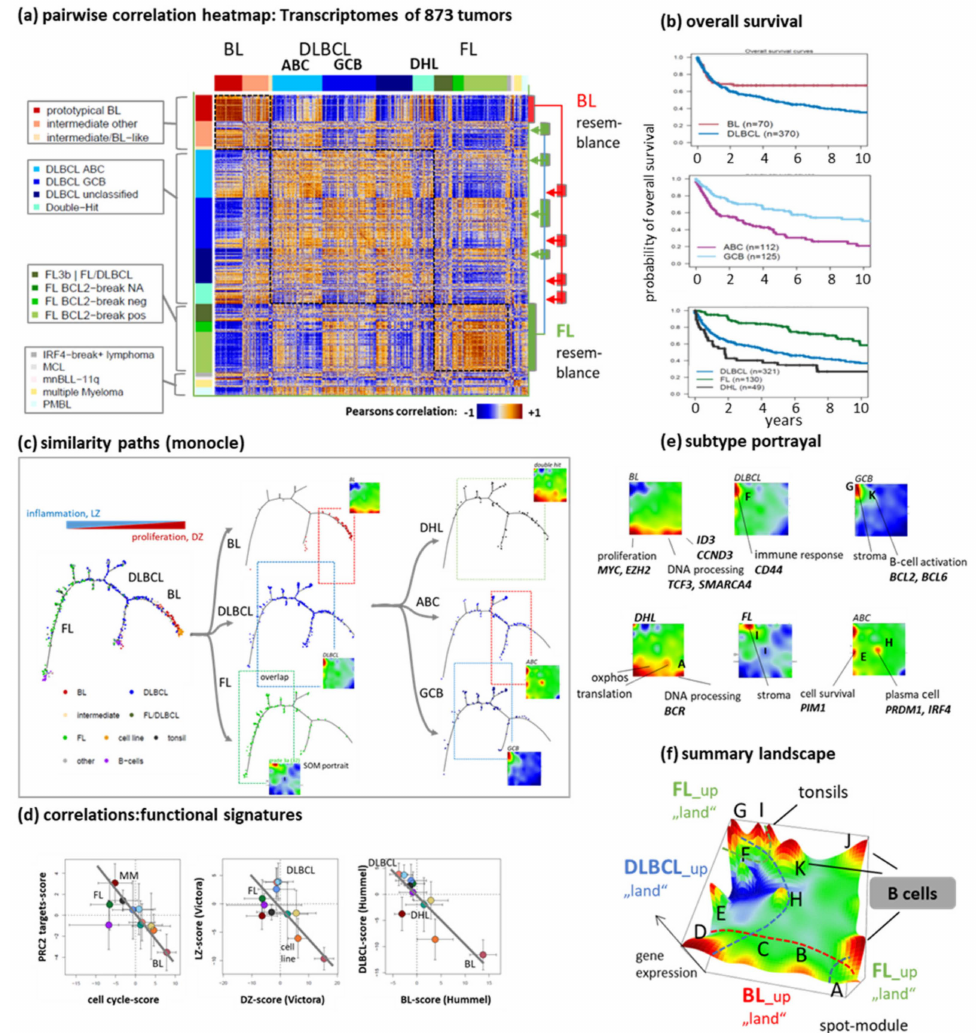
Figure 1. The complex transcriptional landscape of lymphomas: ( a ) The pairwise correlation map reveals a high diversity of similarities (red) and dissimilarities (blue) between different lymphoma strata. The color-code of lymphoma classes is used throughout the paper. ( b ) Overall survival curves reveal different prognoses for the subtypes, which makes diagnostics an important task (survival data were taken from [4]). ( c ) Similarity tree presentations illustrate the distribution of major lymphoma subtypes. They reflect rather a continuum of molecular states than well-separated clusters of lymphoma subtypes. Subtypes considerably overlap (as visualized by the rectangles), which challenges classification based on the gene expression data. A similarity tree was generated using “monocle” [36]. ( d ) Correlation plots show virtually alternate changes of the mean expression scores of different functional context, namely, of targets of the PRC2 (with impact for epigenetic dedifferentiation of cellular programs [37]) as a function of cell-cycle activity; of LZ-versus-DZ activity scores [38] and of DLBCL-versus-BL classification signatures [3]. The grey line serves as a visual guide. ( e ) Transcriptome SOM portraits of selected subtypes obtained from the MMML-cohort show specific expression patterns where red overexpression “spot”-modules are associated with molecular function and key genes (see [4] for details, spots are labelled with capital letters). ( f ) The spot summary map provides an overview about the overexpression spot modules observed in lymphomas (see part e). Spots are assigned with capital letters. Their expression profiles are shown in Figure A3. Spots upregulated in BL, DLBCL and FL are found in distinct areas, “lands” of the landscape which partly overlap (dashed borderlines). “B-cell” functions refer to pre- and post-GC B-cells as well as activated genes of the B-cell receptor pathway (see [4] for